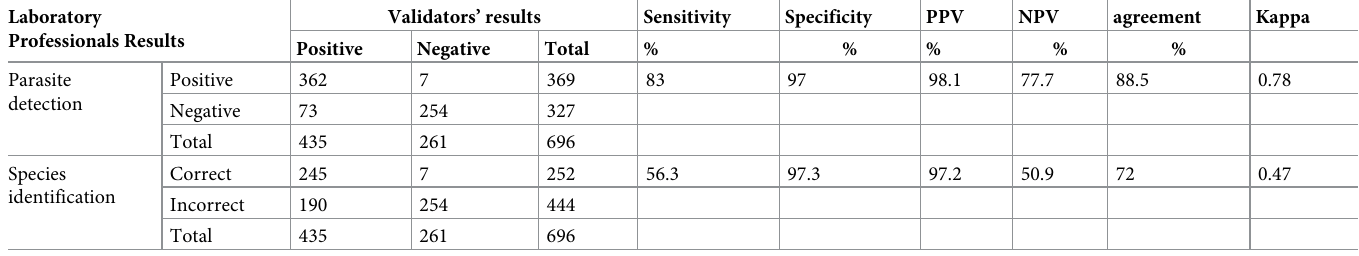
Table 3. Overall sensitivity, specificity, and agreement between the laboratory professionals and validators’ on detection and identification of Plasmodium parasites at health facilities in Bahir Dar city administration from January to March, 2017. Laboratory Professionals Results